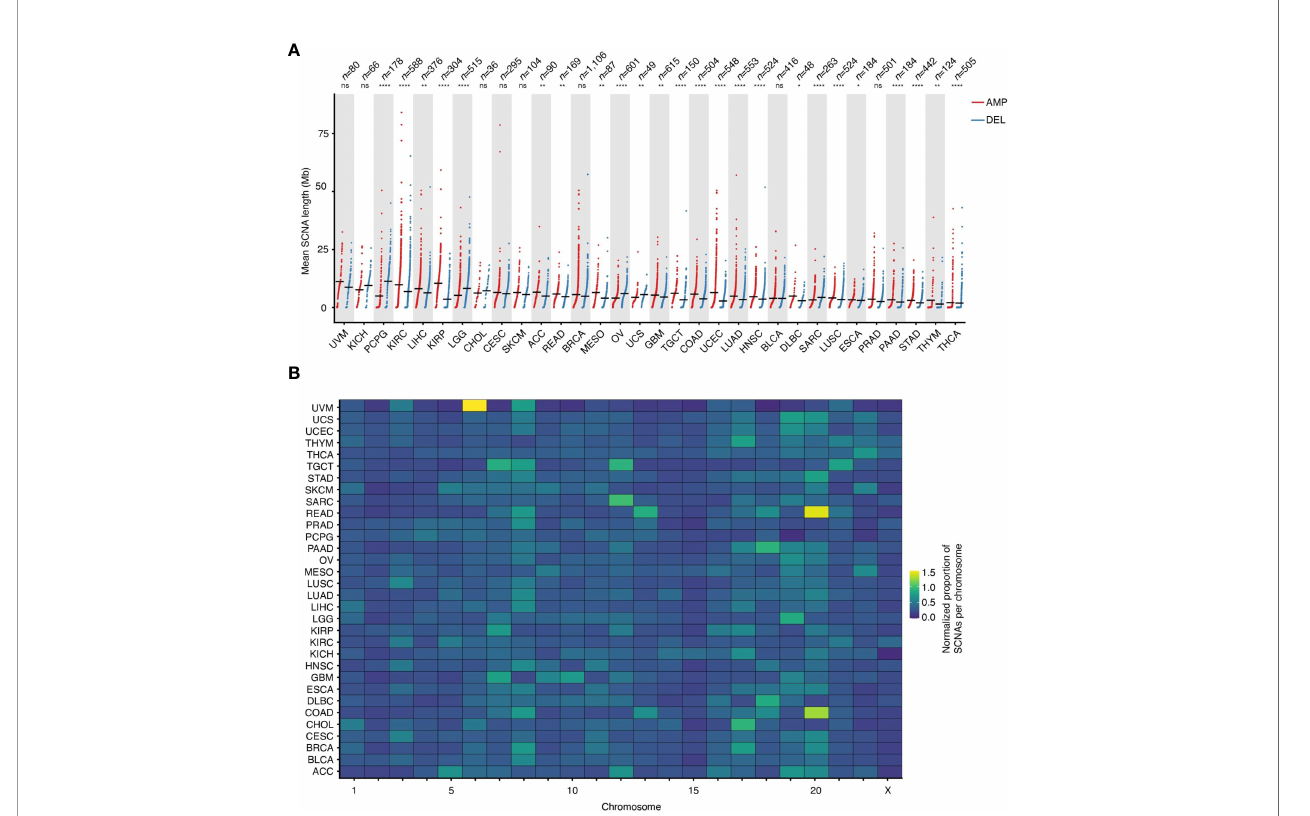
FIGURE 2 | Length and proportion of SCNAs across chromosomes. (A) Length of SCNAs by tumor type, separately for ampli fi cations (AMP) and deletions (DEL). Each dot represents the average alteration length in one tumor sample. Black horizontal bars: mean values. Asterisks indicate statistical signi fi cance levels (Wilcoxon ’ s test, two-sided) at 0.05 (*), 0.01 (**), 0.001 (***) and 0.0001 (****). ns, not statistically signi fi cant. (B) Proportion of SCNAs in each chromosome normalized by chromosome length for each of the 32 tumor types analyzed. The normalization was done as following: (# of SCNAs in a chromosome)/(tot # of SCNAs) * (chromosome length in Mb). See Supplementary Table 4 for the list of tumor type abbreviations